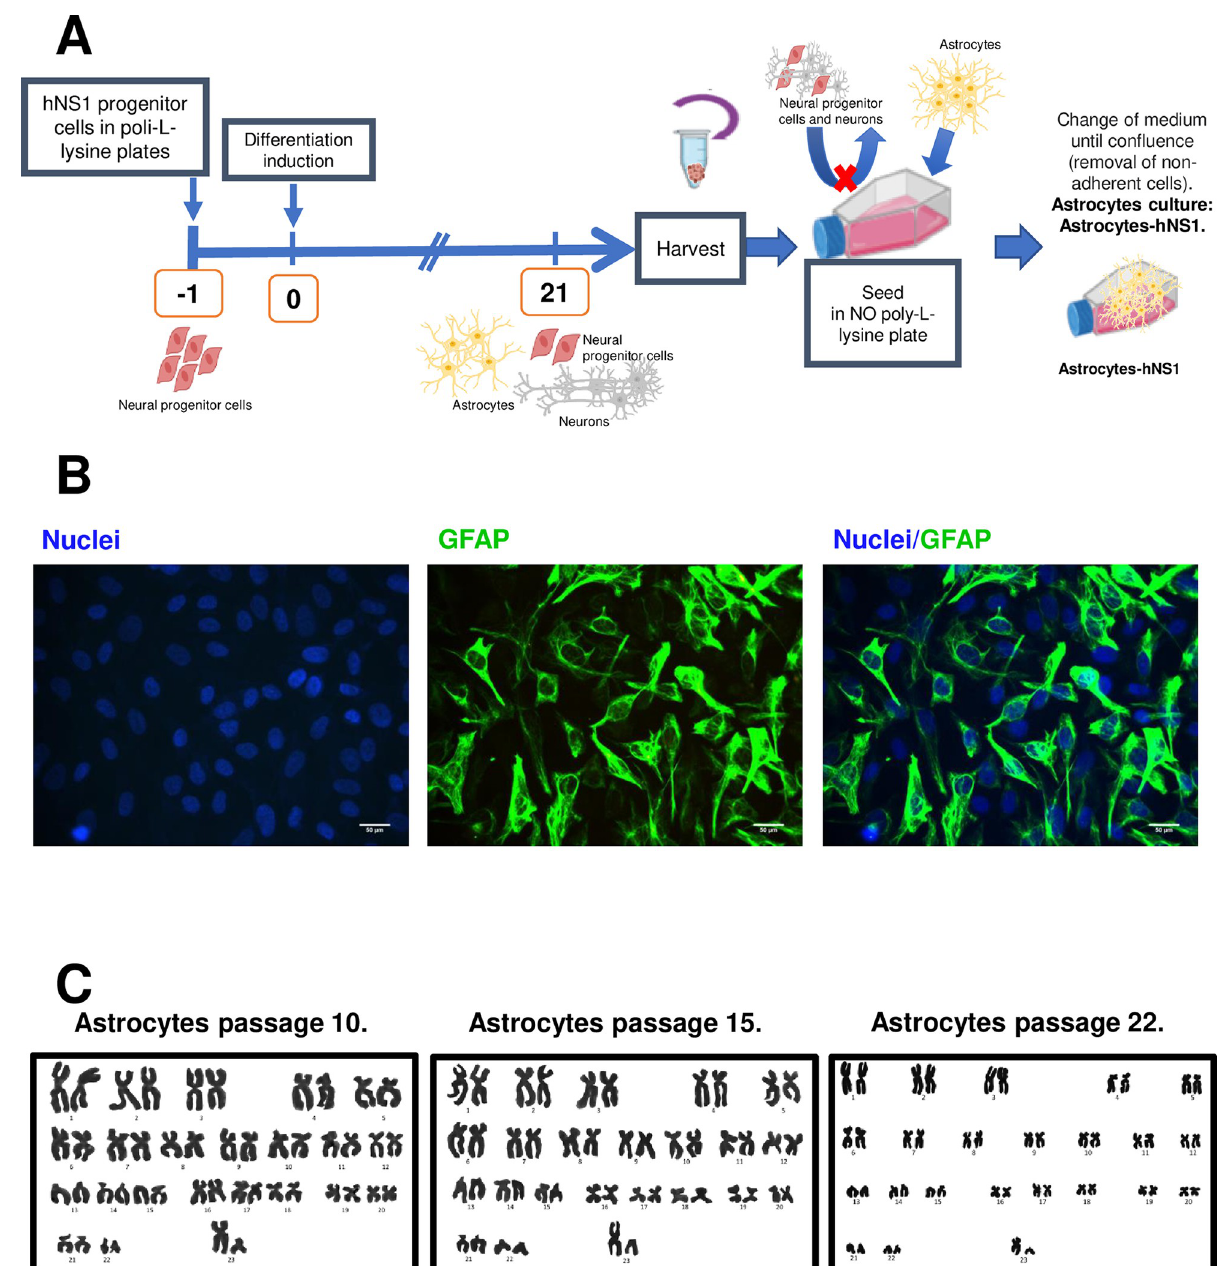
Fig 1. Astrocytes-hNS1 are a pure culture of human astrocytes. hNS-1 cells were differentiated for 21 days. The differentiated cells were harvested and seeded in culture labware without poly-L-lysine treatment and with DMEM. Non-adherent cells (neurons and neural progenitor cells that did not differentiate) were removed by exchanging the media. Astrocytes-hNS1 cells were seeded, and cells were fixed and processed for immunofluorescence using antibodies to GFAP (astrocyte marker). Cells from different passages were used to verify that they maintained a stable karyotype using the karyotyping technique. (A) Diagram of the procedure to obtain a pure culture of astrocytes-hNS1. (B) Representative micrographs of GFAP immunofluorescence in cultured astrocytes. Scale bar 50 μ m. (C) Reconstruction of the karyotype of three passages of astrocytes-hNS1. https://doi.org/10.1371/journal.pone.0283429.g001 expression of the glial transcripts GFAP , SLC1A3 (encodes EEAT1 ) , SLC1A2 (encodes EEAT2), GLUL (encodes GS ) , GRIN1 (encodes N-methyl-D-aspartate Subunit 1 Receptor,